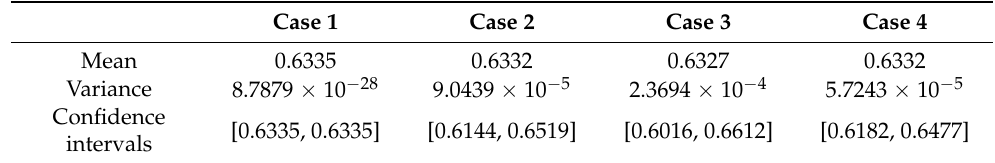
Table 2. Importance measure indicators of components in four cases ( T = 7 h, S = C = 1000). 𝜂 (cid:2869)(cid:2870) Case 1 Case 2 Case 3 Case 4 η 2